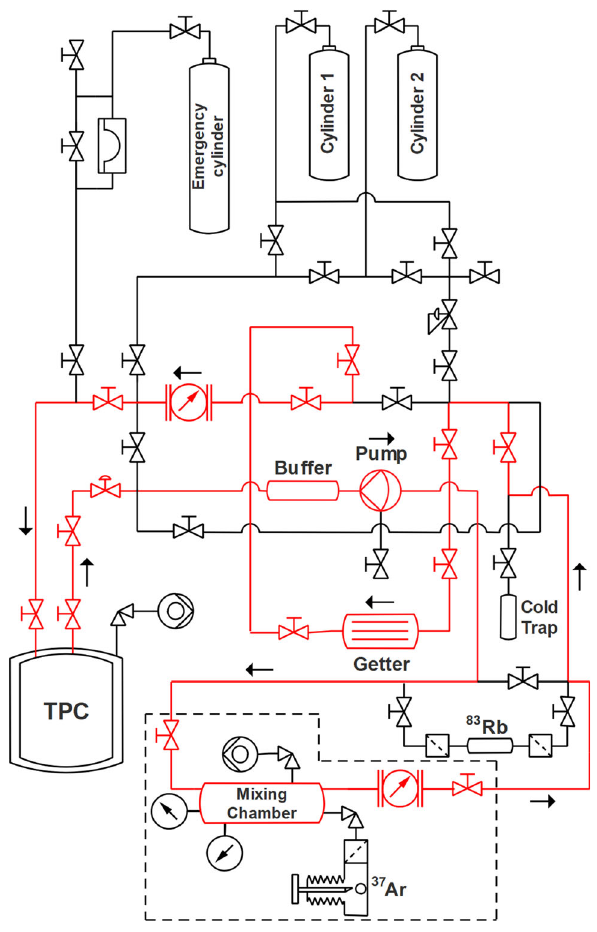
Fig. 2 Piping and instrumentation diagram of the gas system and the added 37 Ar setup (framed with a dashed line). The gas recirculation path to introduce the source into the xenon flow is indicated in